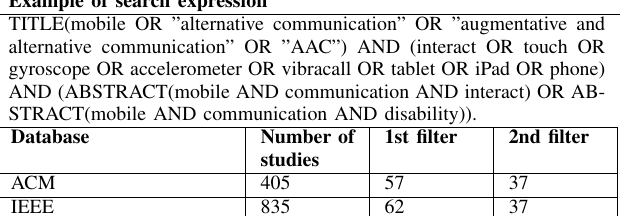
Example of search expression TITLE(mobile OR ”alternative communication” OR ”augmentative